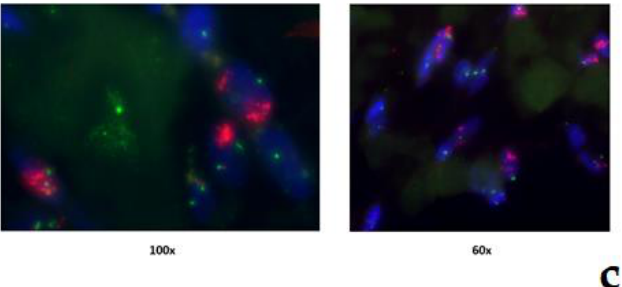
Figure 12. Low-grade central osteosarcoma, showing a lytic lesion the distal femur on X-ray ( a ). On histology, the tumor strongly mimics fibrous dysplasia, with the very irregular bone trabeculae embedded in e fibrous stroma ( b ). The amplification of the MDM2 gene supports the diagnosis ( c ).